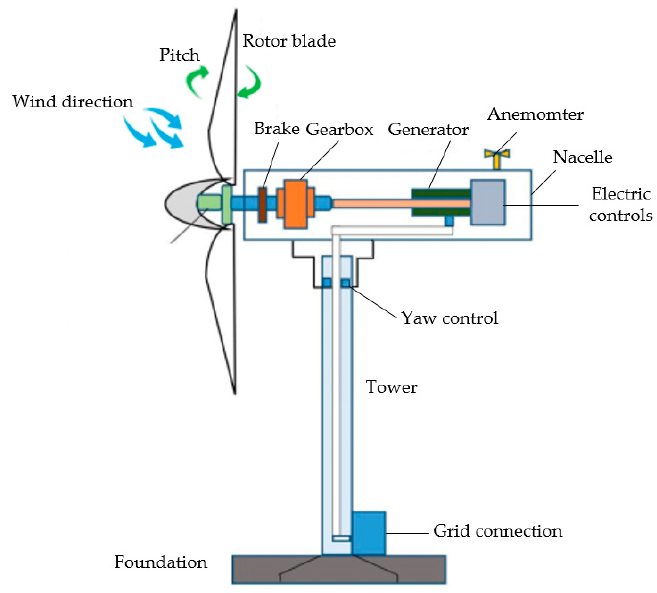
Figure 2. Three-blade horizontal axis wind turbine [23].